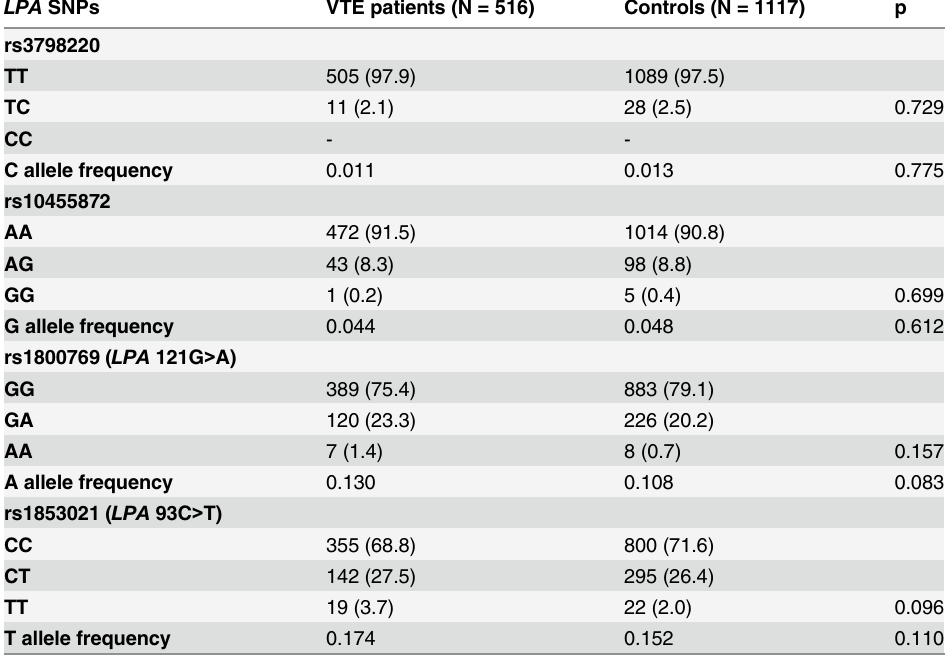
Table 3. Genotype distribution and minor allele frequency of the 4 LPA single nucleotide polymor- phisms (SNPs) investigated.